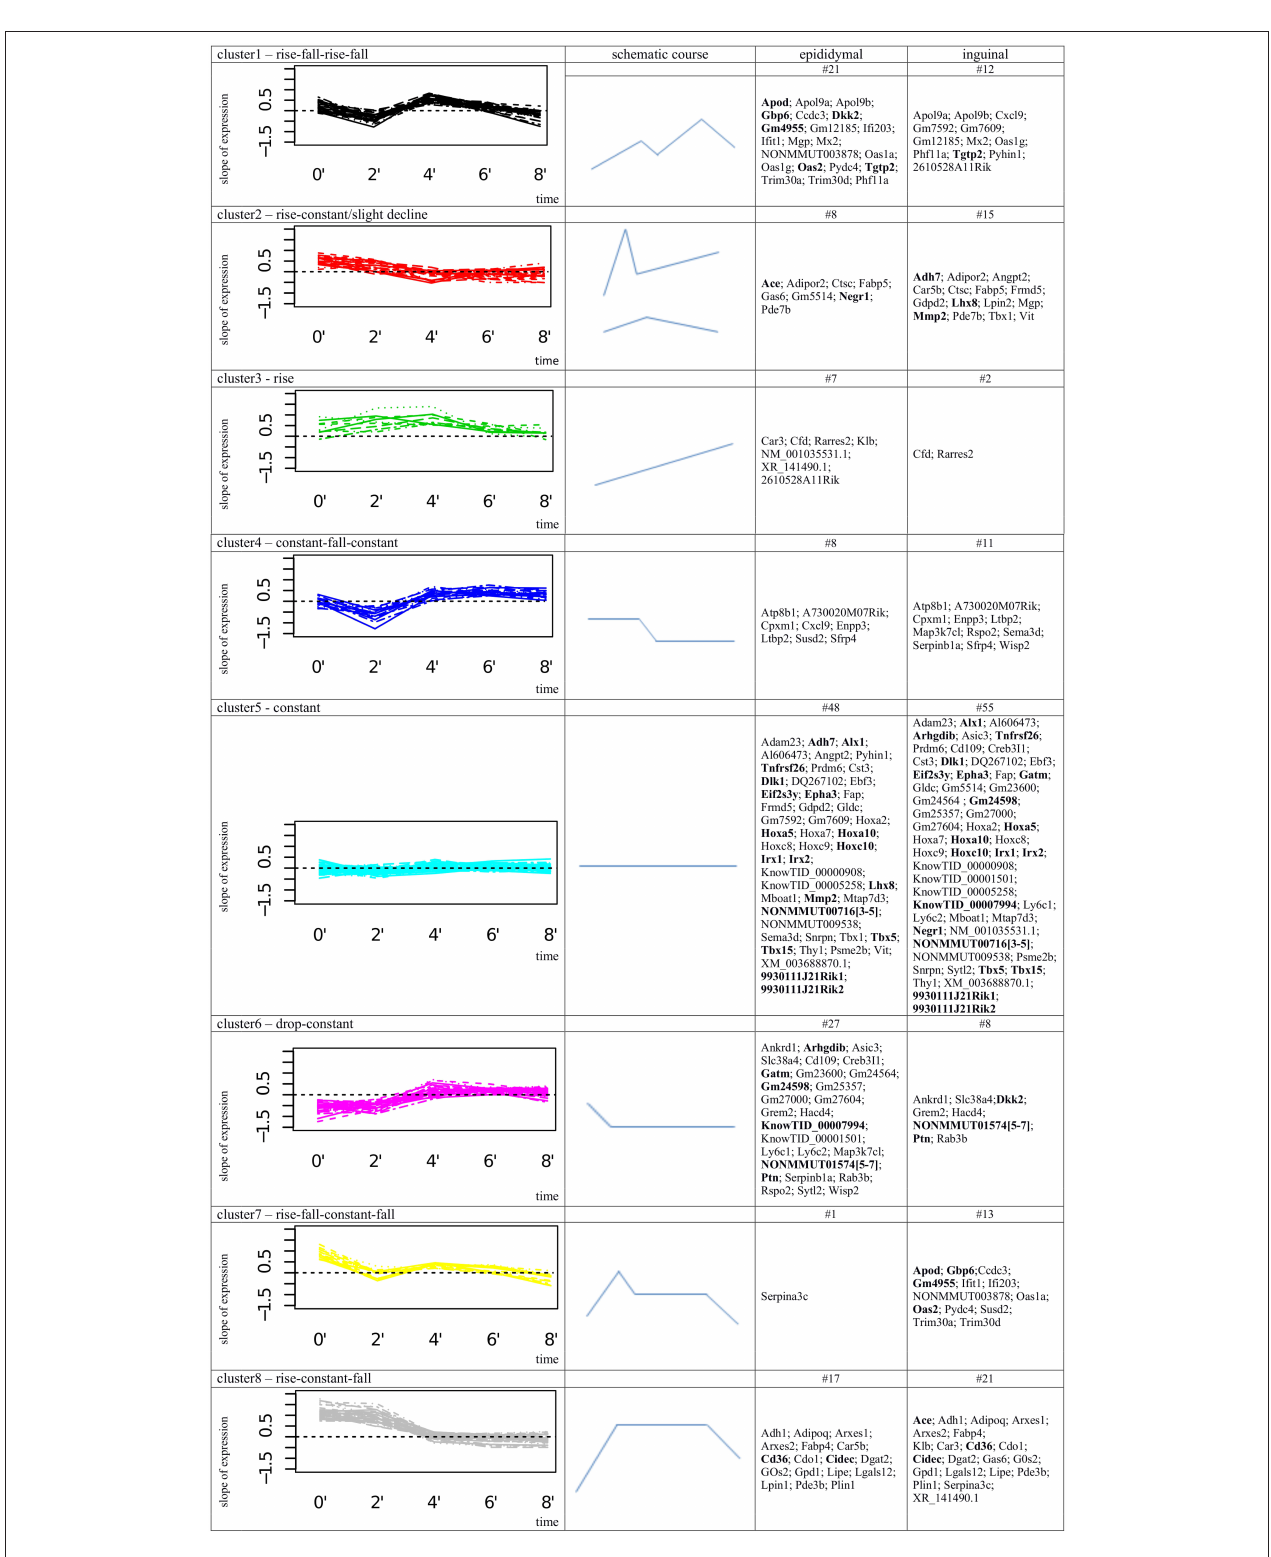
FIGURE 2 | Cluster analysis of 137 most differentially expressed genes between epididymal and inguinal adipogenesis. In column 1 the figure shows the clusters of gene expression intensity slopes (x’ i ), the schematic shape of the according expression profile is provided in column 2; column 3; and 4 list the gene symbols assigned to the cluster in epididymal or inguinal cell line. # provides number of genes in single cluster corresponding to epididymal or inguinal cell line; Bold gene names highlight the top 34 genes.